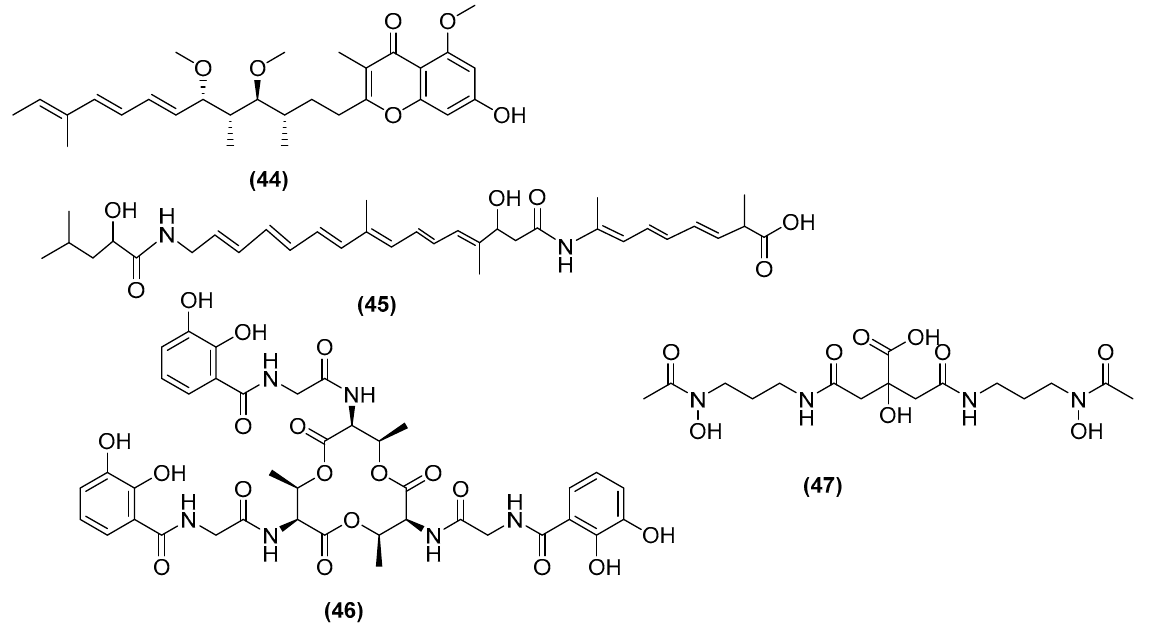
Figure 11. Chemical structures of stigmatellin Y ( 44 ), bacillaene ( 45 ), bacillibactin ( 46 ), and schizokinen ( 47 ).